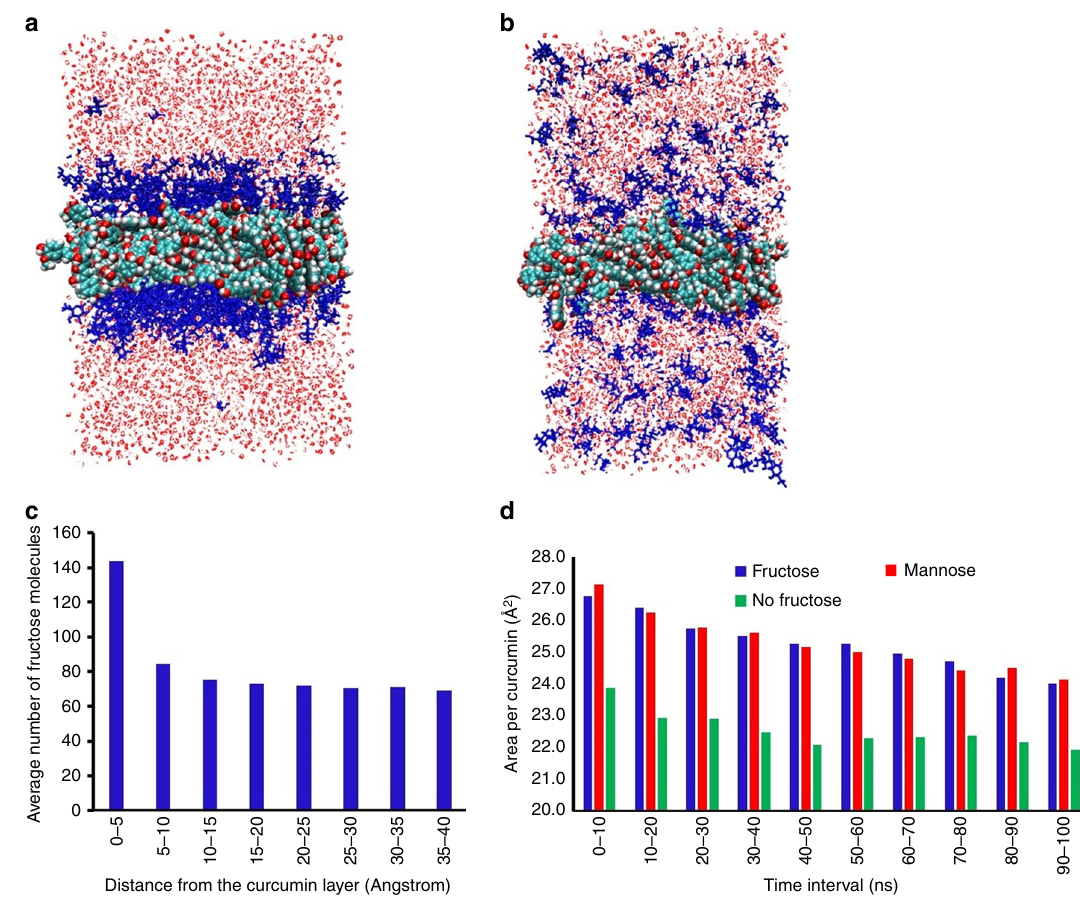
Fig. 3 Snapshot from the molecular dynamics (MD) trajectory of a fructose – curcumin – fructose membrane model a prior to equilibration and b after equilibration. c The MD simulations indicate that there is a concentration gradient of fructose molecules that decreases with increasing distance from the curcumin layer. d The average area per curcumin at various time intervals along a 100 ns trajectory for simulations with and without fructose, and with